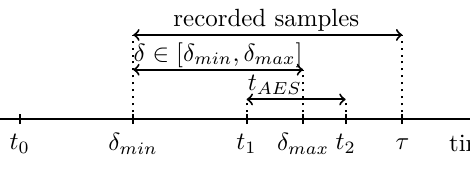
Figure 5: Timing of various events that occur during the acquisition of an EM trace. Once the side-channel acquisition is over, the attacker has to align the EM traces. The timing of different events that occur during the acquisition of a trace are shown in Figure 5. The injected message is sent at t 0 and the oscilloscope is triggered. The oscilloscope